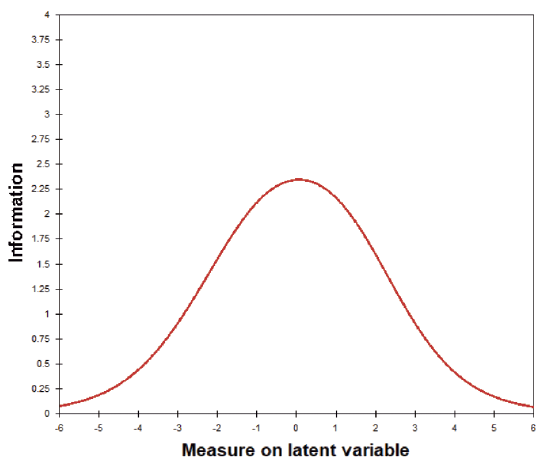
Figure 3. Graph of measurement information